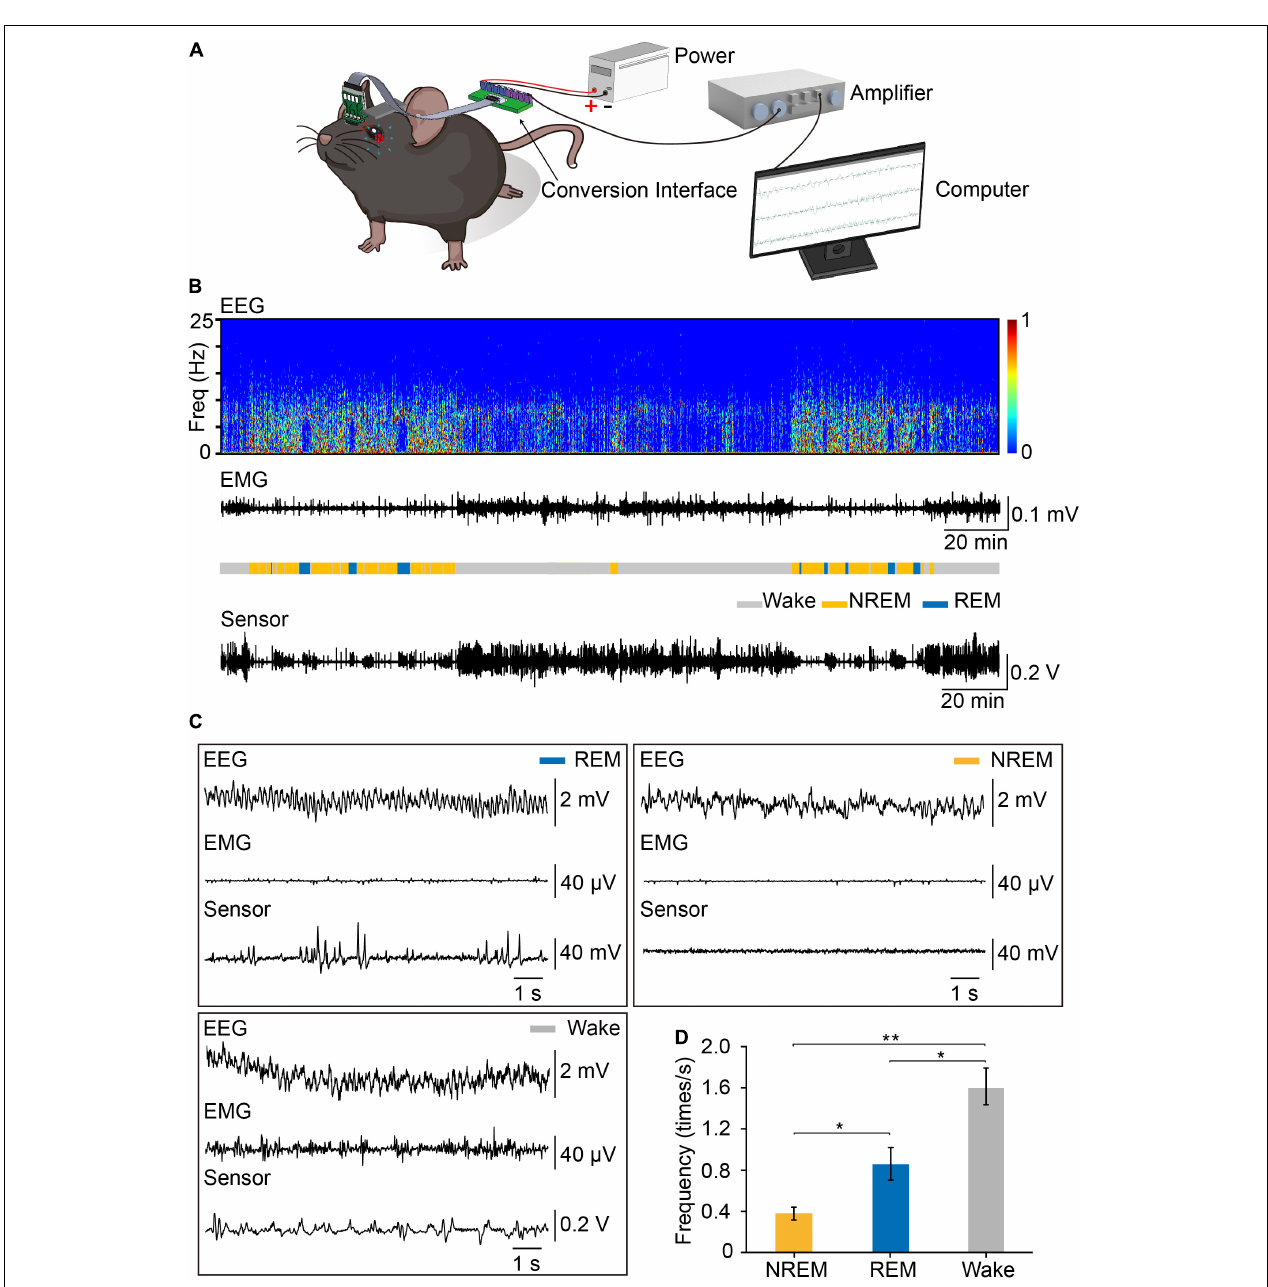
FIGURE 4 | Recording EEG, EMG and eye movements by the device during the sleep–wake cycle. (A) Set-up of system for recording EEG, EMG, and eye movements. The signals of EEG, EMG, and eye movements were detected by the device, transferred through FPC, amplified through an amplifier and recorded by Spike2 for analysis. (B) Representative data showed EEG power spectrogram, electromyogram amplitude, brain states, and eye movements curve. Sleep pattern of representative data: Wake:147 min, NREM: 70 min, REM: 23 min. (C) Example of EEG, EMG, and eye movements raw traces during REM (left) , NREM (right) , and wakefulness (left) . (D) Eye movements frequency during different brain states ( n = 3, One-way repeated measures ANOVA followed by post hoc comparison with Tukey’s correction). Data are expressed as mean ± SEM, * p < 0.05, ** p < 0.01.